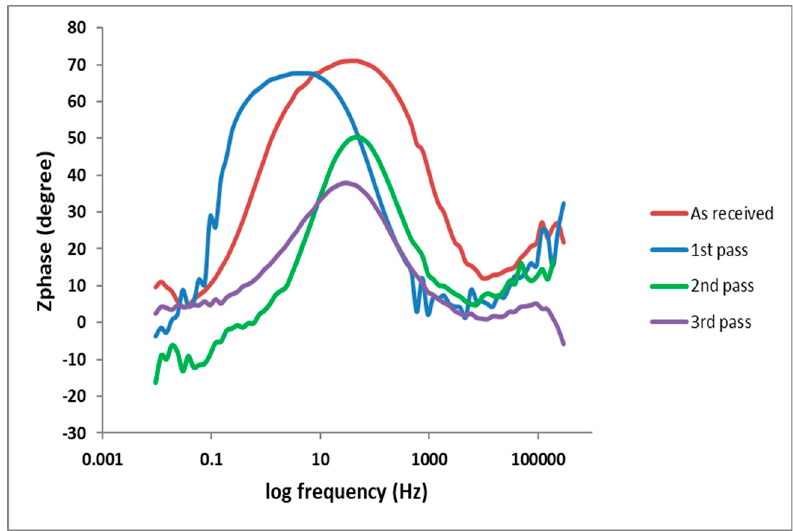
Figure 5. EIS Bode angle plot of the Al5083 alloy in the 3.5% NaCl solution.